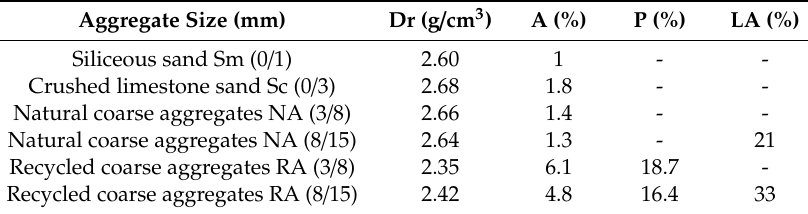
Table 2. Properties of the aggregates.